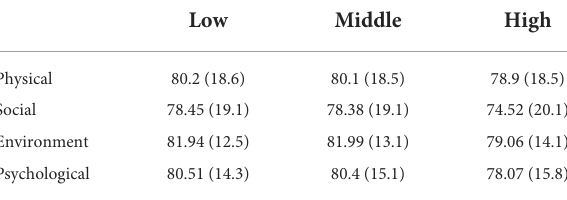
TABLE 2 Mean (SD) quality of life scores in the pre-pandemic data according to population density (Moons et al., 2006). Low